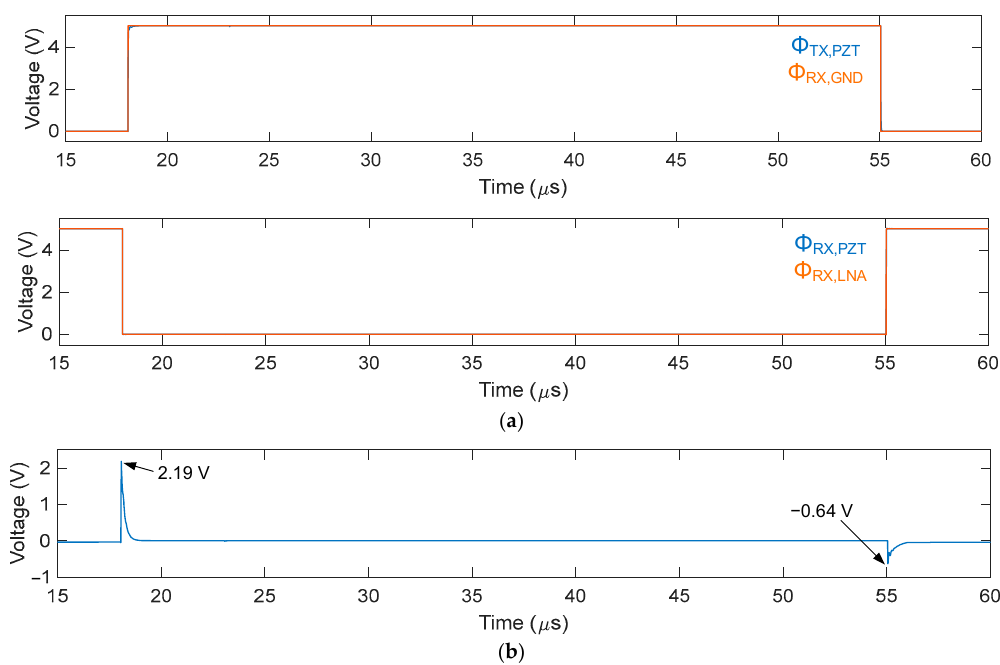
Figure 5. Simulated waveforms of the element-level circuit implemented in the first-generation ASIC (Figure 4): ( a ) control signals driving the element-level switch circuit and ( b ) the switching transients on the transducer element.